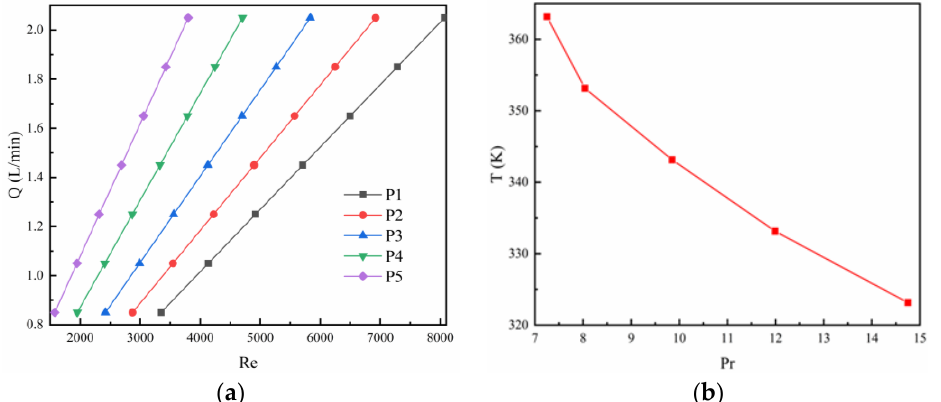
Figure 2. Distributions of flow ( a ) and temperature ( b ).